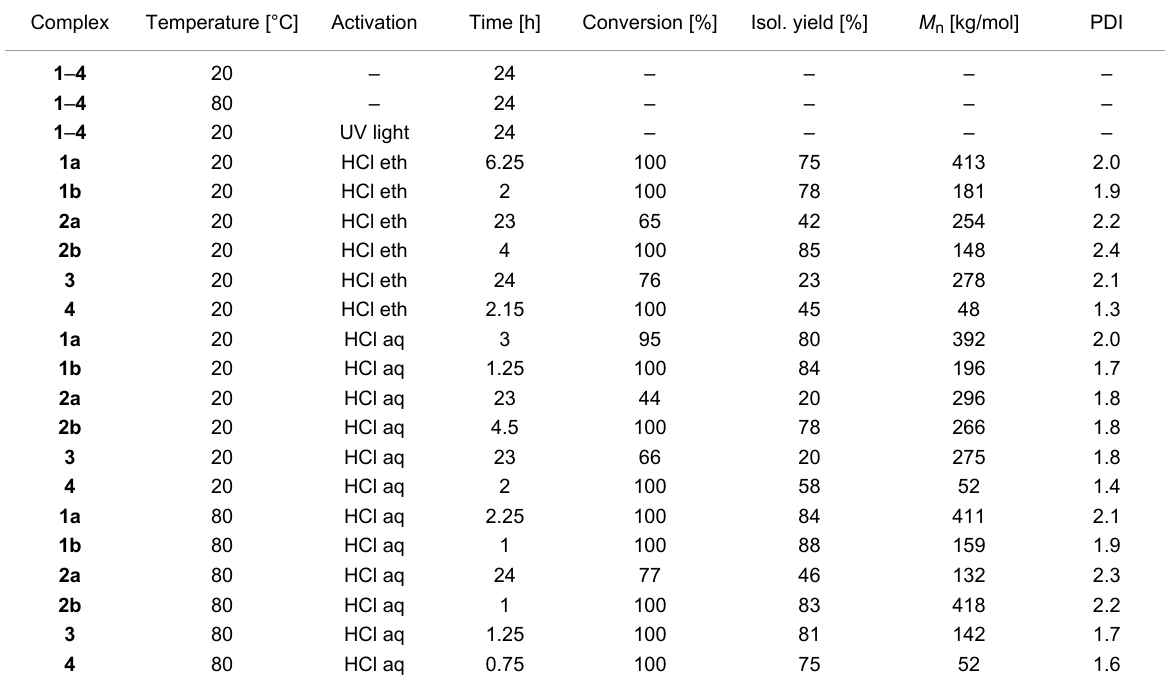
Table 1: Polymerization of 5 by preinitiators 1 – 4 (eth = ethereal; aq = aqueous; molecular weights ( M n ) and the corresponding polydispersity indices (PDI) were determined using gel permeation chromatography (GPC) against polystyrene standards).